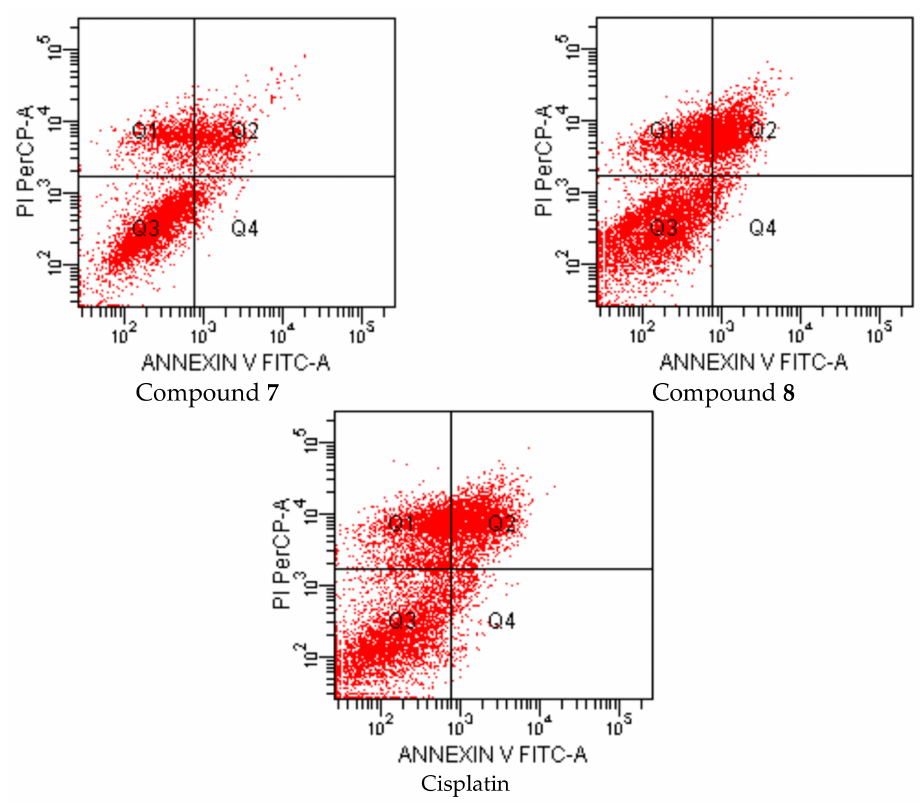
Figure 2. Flow cytometric analysis of C6 cells treated with IC 50 values of compounds A , 6 , 7 , 8 and cisplatin for 24 h. At least 10,000 cells were analyzed per sample, and quadrant analysis was performed.